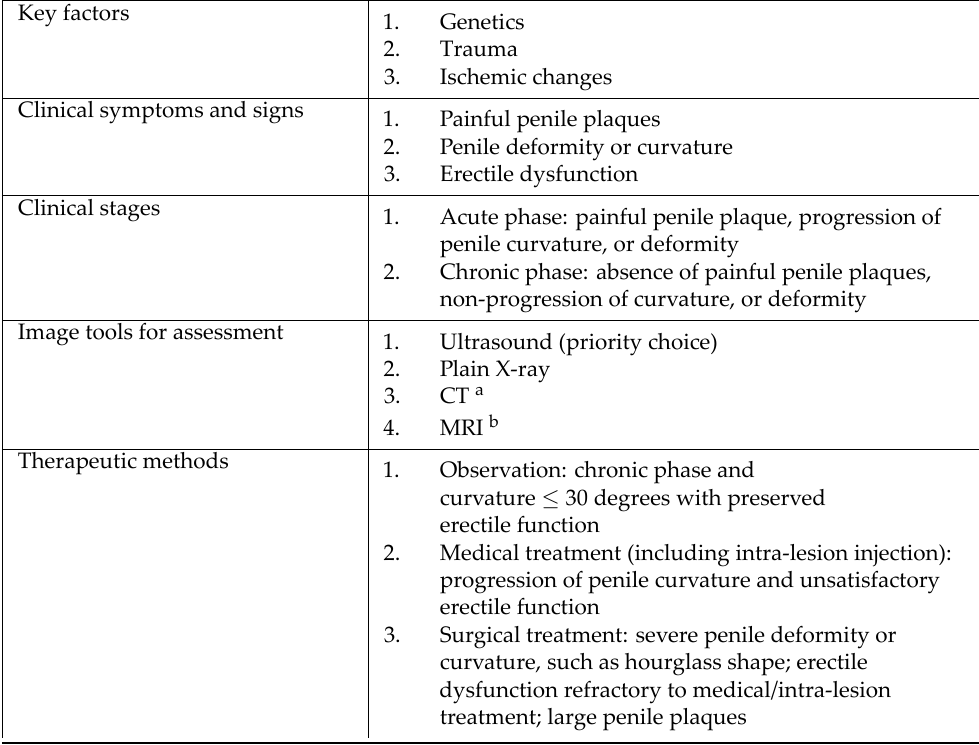
Table 1. The summary of PD and its current treatment options. a Computed tomography; b Magnetic resonance imaging; c Collagenase Clostridium Histolyticum; d Calcium channel blocker; e